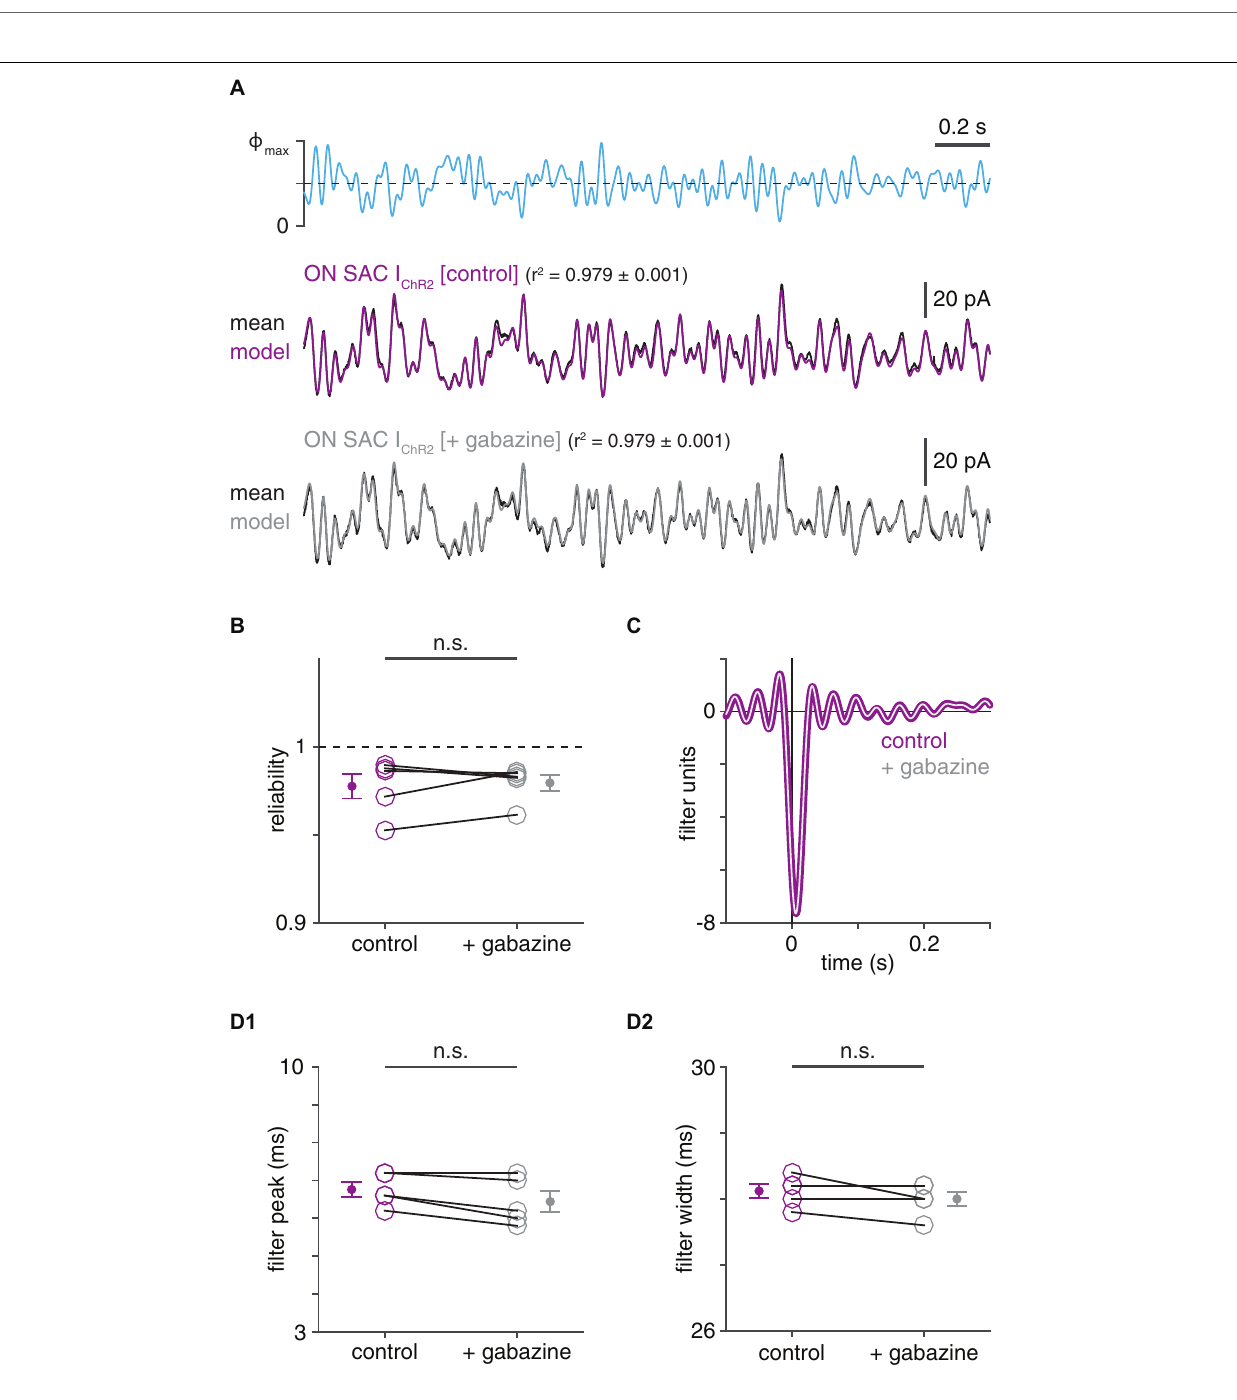
Frontiers in Cellular Neuroscience |